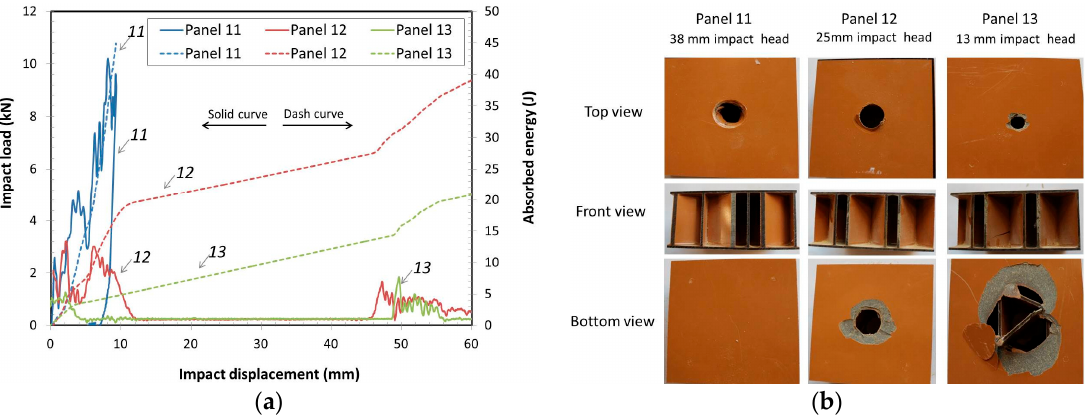
Figure 7. Impact energy 40 J: ( a ) Impact load and absorbed energy vs. impact displacement by different impact heads; ( b ) Failure modes of panels by different diameter impact heads.